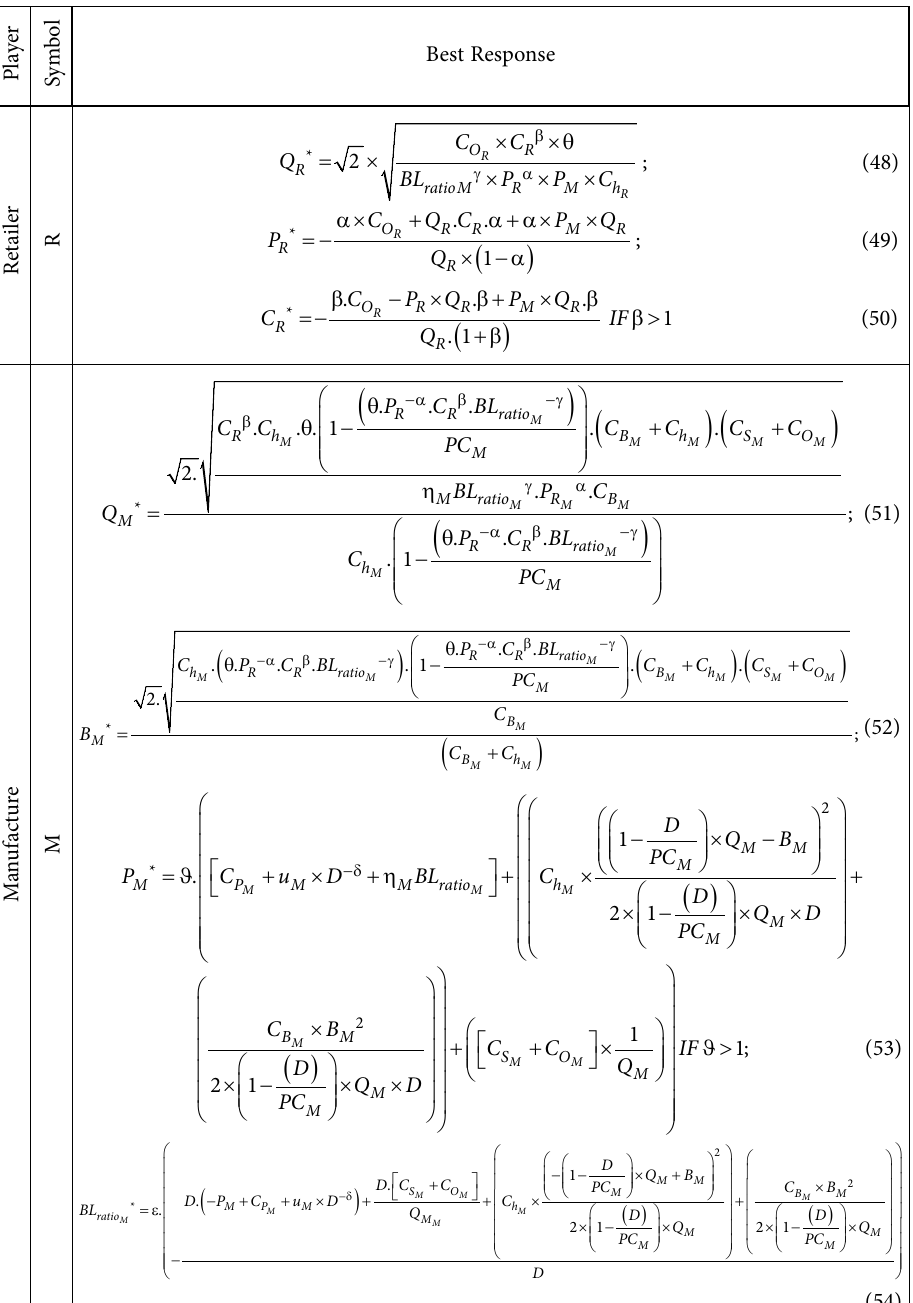
Table 11. Best responses of retailer and manufacturer o l e r b m a y P l S y